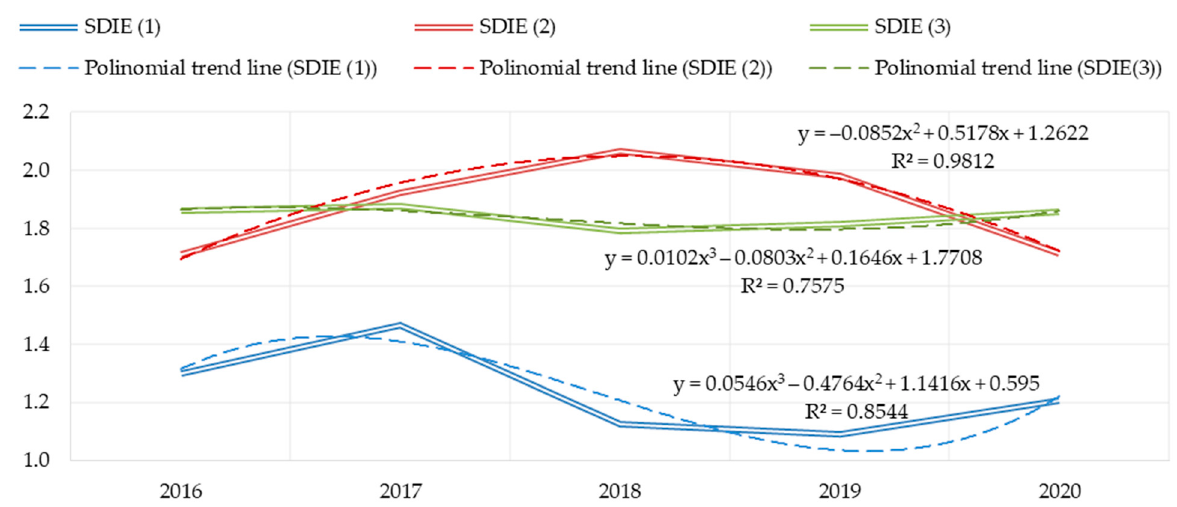
Figure 5. Integral indicator of sustainable development of the industrial enterprise SDI E and graphs of the approximating function (polynomial).